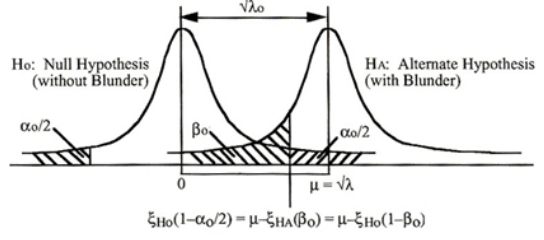
√ λ 0 (fromVaníek et al., 0 , β 0 and